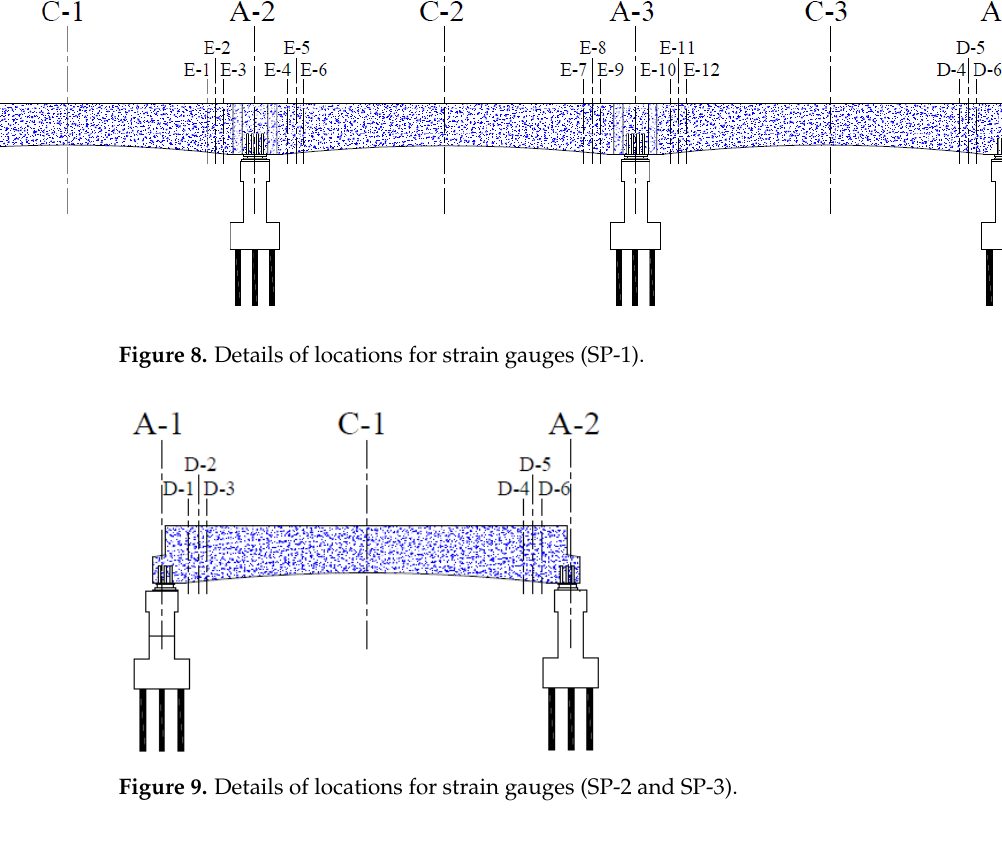
( d ) Figure 10. Details of end sections at locations ( a ) A-1, ( b ) A-2, ( c ) A-3 and ( d ) A-4 (units: mm).